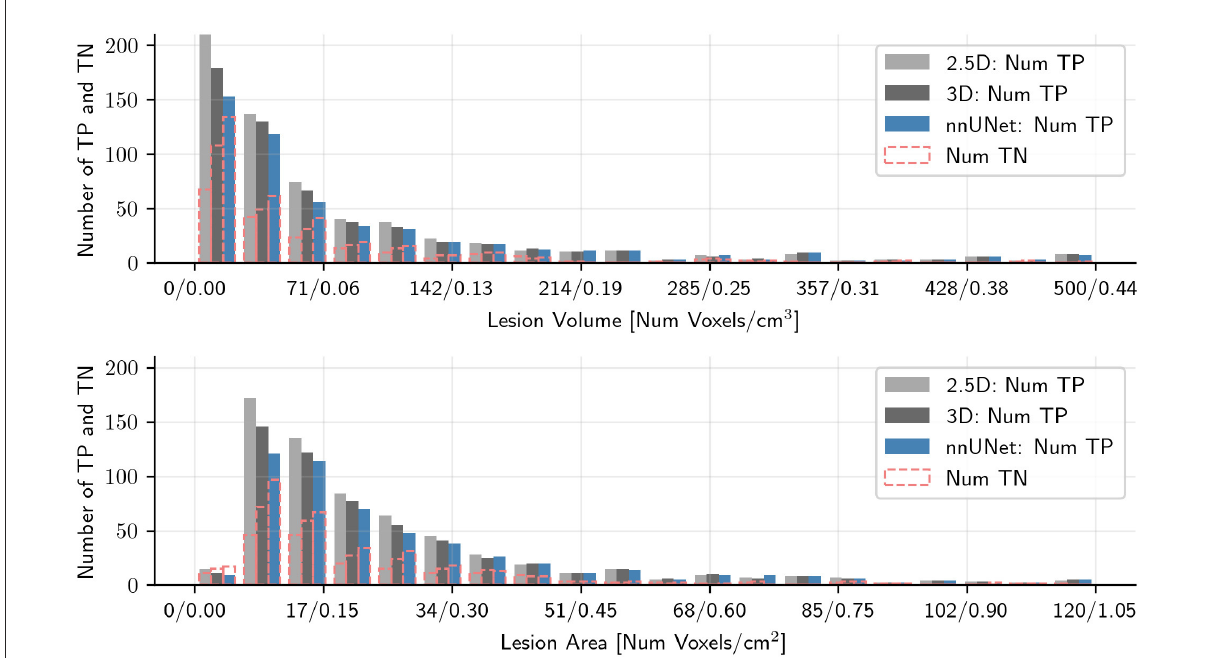
FIGURE3 Histogram plots of the number of correctly predicted metastases and the number of missed metastases as a function of the maximum metastatic area in the axial plane and metastatic volume for the Stanford patient test cohort for all three models tested. Metastases larger than 120 (area) or 500 (volume) voxels were excluded to improve readability. TP denote true positive metastases, i.e., correctly predicted metastases, and TN denotes true negative metastases, i.e., not predicted